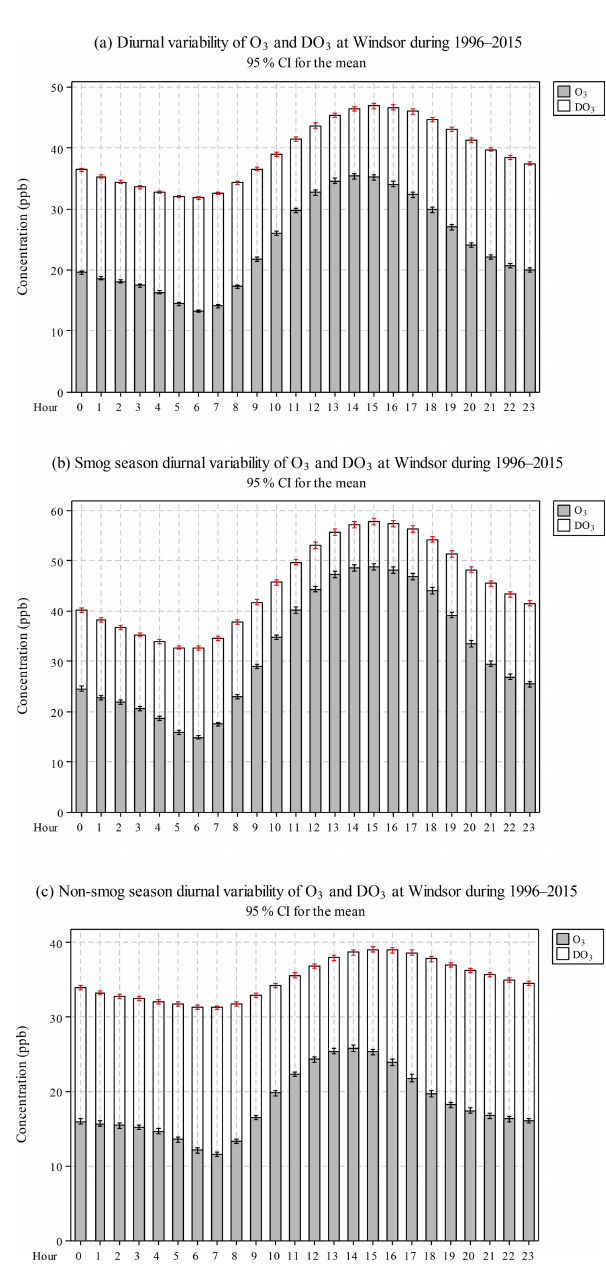
Figure 2. Diurnal O 3 and DO 3 concentrations during 1996–2015 in Windsor for (a) all months, (b) smog season, and (c) non-smog season. CI stands for confidence